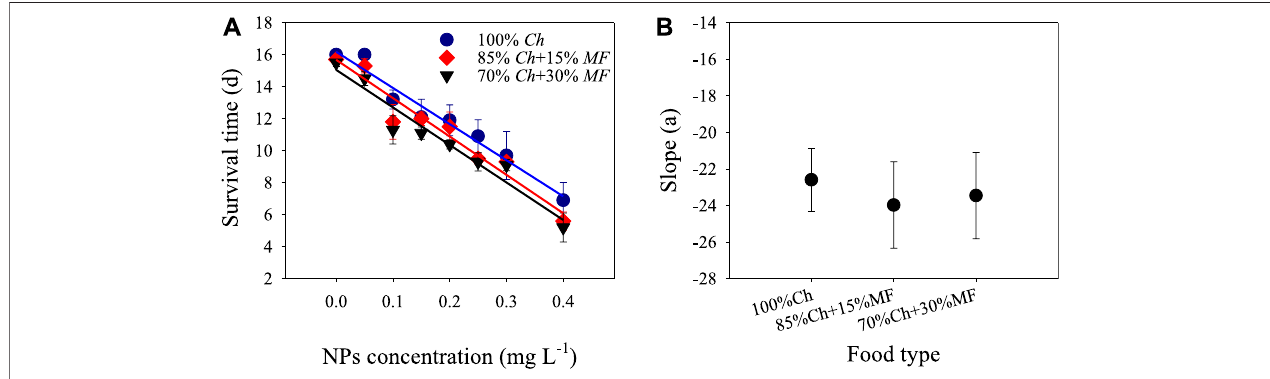
FIGURE 2 | Development indicators and their slopes of D. magna under different conditions. Some error bars were too short and covered by the data symbol. Different lowercase letters in the fi gure represent signi fi cant differences.